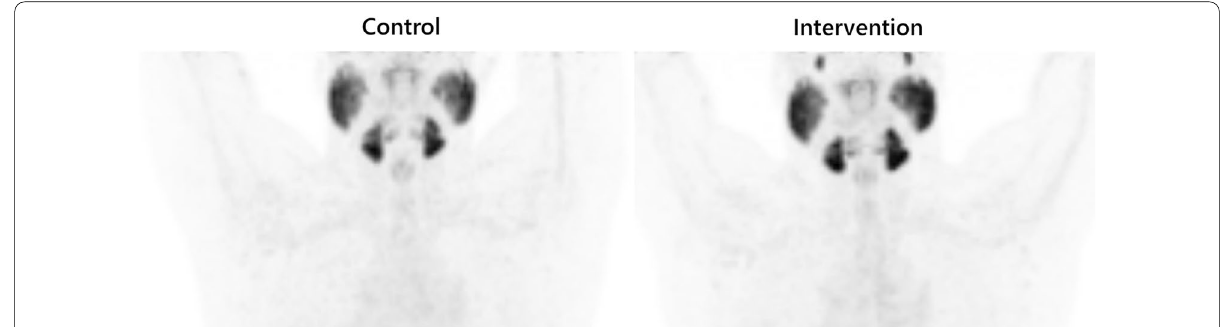
Fig. 1 Coronal maximum intensity projections of the head and neck region from control and intervention [ 18 F]DCFPyl PET scans of patient number 1. This patient demonstrated a 11.5% increase in parotid gland SUL mean after gustatory stimulation